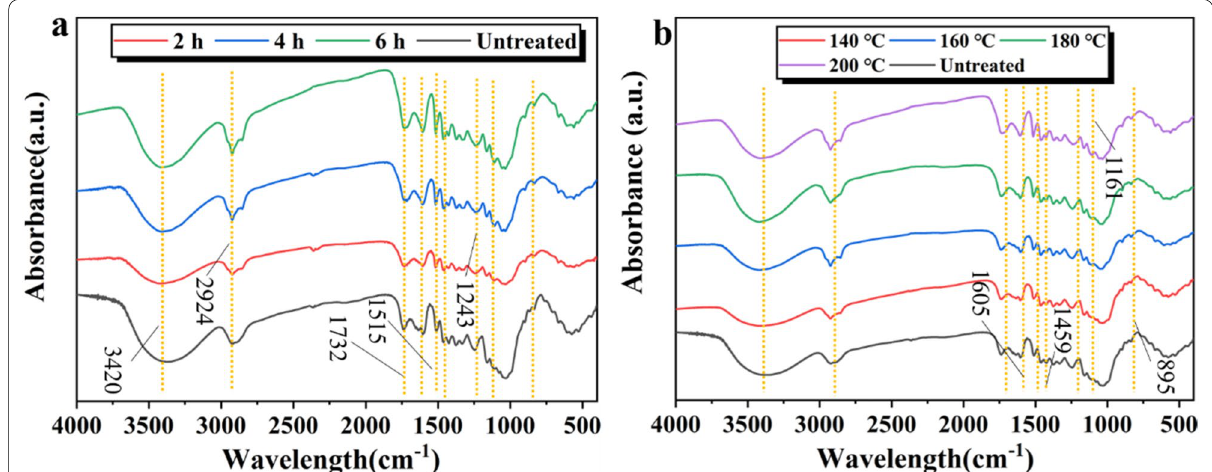
Fig. 4 FTIR spectra of untreated sample and the treated samples treated a at 200 °C for varied time (2, 4 and 6 h) and b at varied temperature (140, 160, 180 and 200 °C) for 6 h,